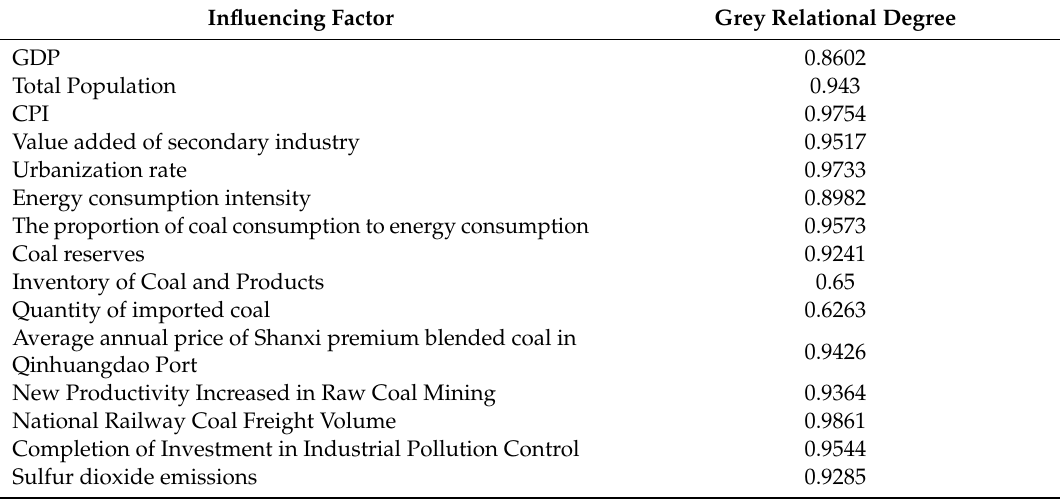
Table 1. The calculation results of the grey relational degrees for influencing